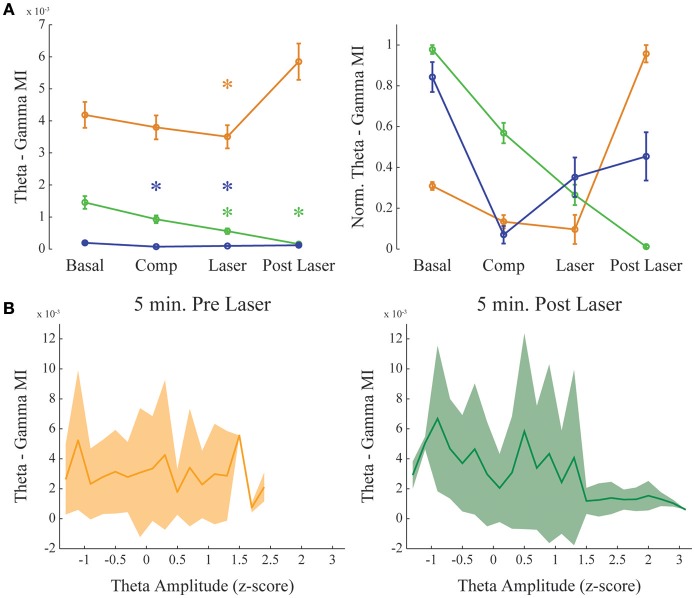
Dopamine uncaging has no effect in theta-gamma comodulation level. Same as in Figure 4, but for theta—gamma coupling. (A) Group result showing raw (left) and normalized modulation index (right) for the theta-gamma comodulation in the 4 experimental conditions. “Basal” and “Post-Laser” conditions were calculated from periods of active waking in the corresponding part of the experiment, to allow analysis of theta-gamma comodulation. Comp: 10 min after compound injection. Laser: 1 min irradiation. Each color represents one animal, and all recording channels were pooled together per recording session. Friedman's statistical test, Tukey's post-hoc test. (p < 0.05). Error bars represent SEM (N = number of channels for each animal; orange: 14 channels; green: 13 channels; blue: 10 channels). Asterisks represent statistically significant differences in comparison with basal recordings. (B) Group results comparing theta—gamma coupling 5 min before and after laser onset while controlling for normalized theta amplitude. Solid line represents the mean and shaded area the standard deviation.